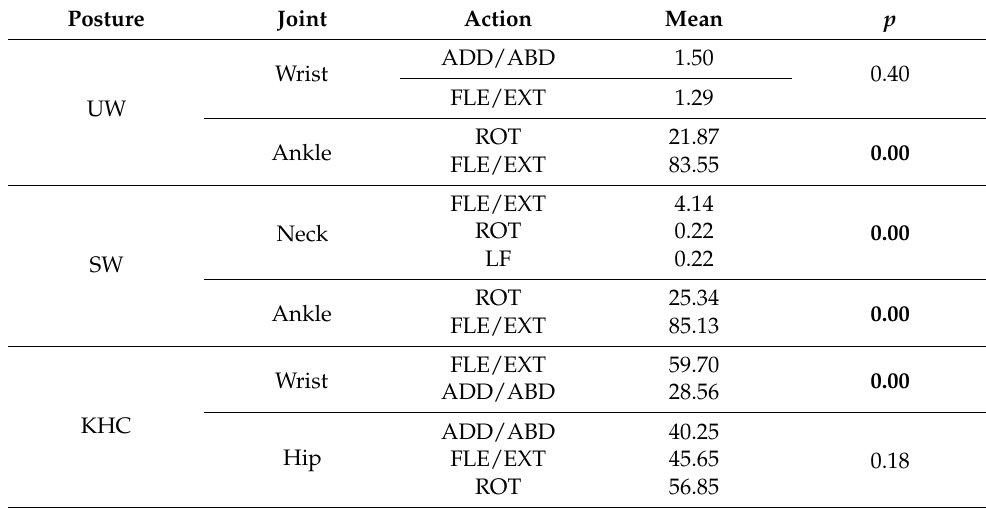
Table 2. Kinematic characteristics of joints in different